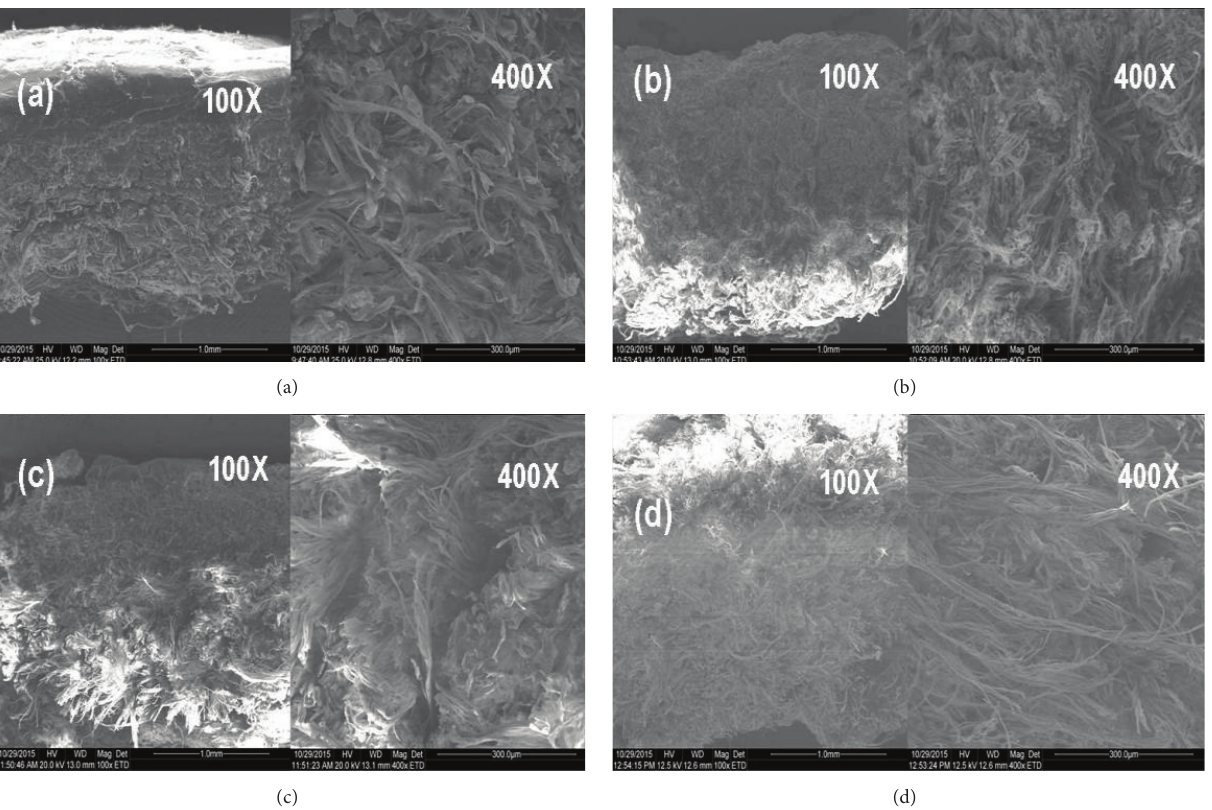
Figure 7: Scanning electron micrographs showing the cross section (100x and 400x). (a) Tanned with chrome tanning agent prepared from the untreated chromium waste liquid. (b) Tanned with chrome tanning agent prepared from the chromium waste liquid treated with enzyme. (c)TannedwithchrometanningagentpreparedfromthechromiumwasteliquidtreatedwithFenton. (d)Tannedwithcommercialchromium